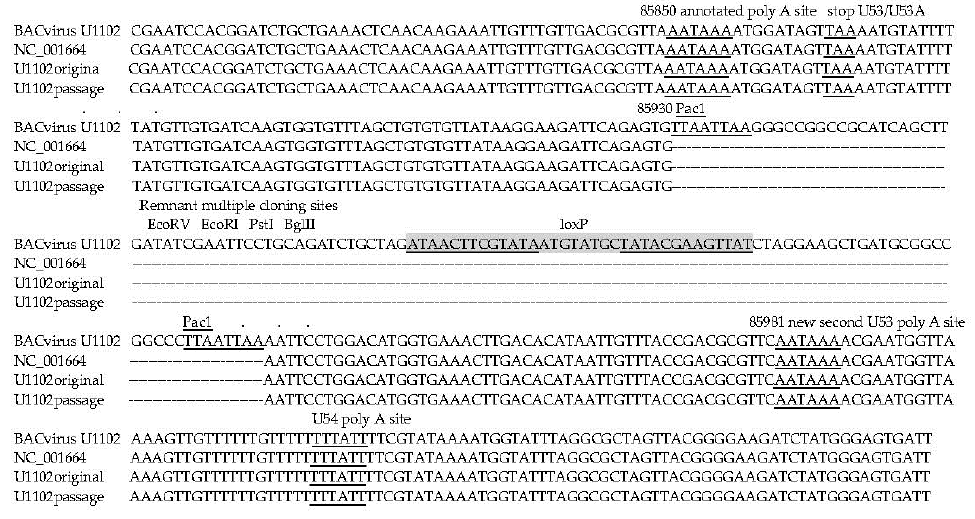
Figure 1. Passaged bacterial artificial chromosome (BAC)-virus deletes the green fluorescent protein (GFP) cassette. In the BAC virus, the GFP cassette disrupts the U53/U53a transcriptional control elements, and after tissue culture passage it is deleted. Shaded and underlined are palindrome1, palindrome 2, and LoxP sites; note the insertion is in an end repaired EcoRI site. Underlined are the original and new poly A regulatory sequences disrupted by the BAC cassette.